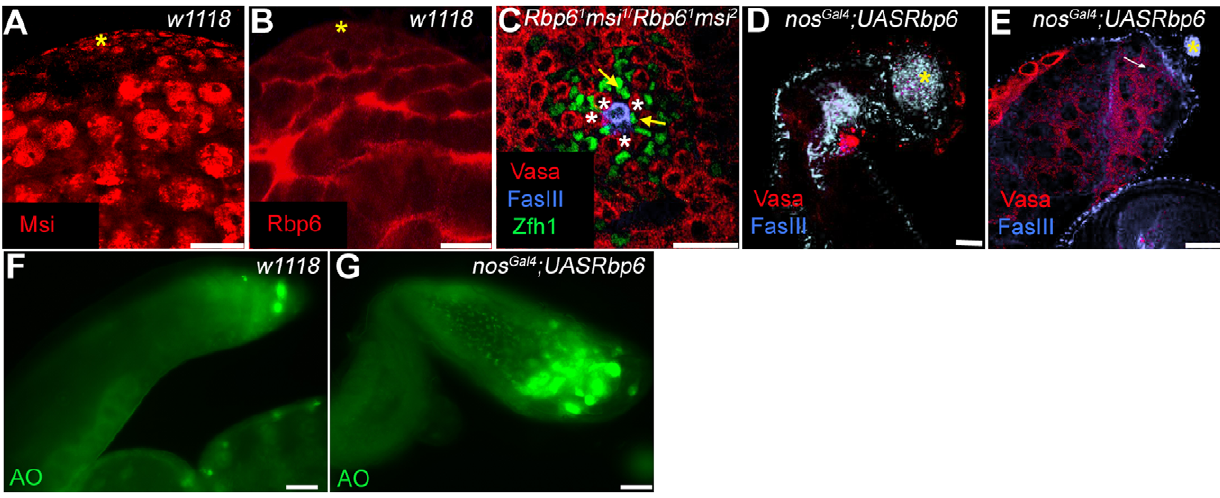
Figure 7. Rbp6 and Msi do not function co-operatively to regulate GSC identity, but mis-expression of Rbp6 causes loss of germ cells through apoptosis. (A) Msi expression (red) in a w 1118 third instar larval testis is nuclear and found in germ cells of all stages. (*) denotes the hub. (B) Rbp6 antibody expression (red) is cytoplasmically localised to the cyst cells of the w 1118 third instar larval testis. (C) A representative confocal micrograph of a Rbp6 1 ,msi 1 /Rbp6 2 ,msi 2 2 day old adult double mutant testis containing germ cells (red) of varying stages, from GSCs (*) to spermatocytes. CPCs (Zfh1, green) abut the hub (FasIII, blue) and take over positions where GSC’s have been lost (arrows) as a result of the msi mutation. No enhancement of the msi mutant phenotype was observed. (D–E) nos Gal4 ; UAS-Rbp6 mutant testes vary from containing no germ cells (red, D) to containing only large spermatocytes in close proximity to the hub (white arrow, E). Acridine Orange labelling of w 1118 testes (green, F) and nosGal4 ; UAS-Rbp6 mutant testes (green, G) reveal more cell death in mutant tissue. Scale bars: 20 m m.